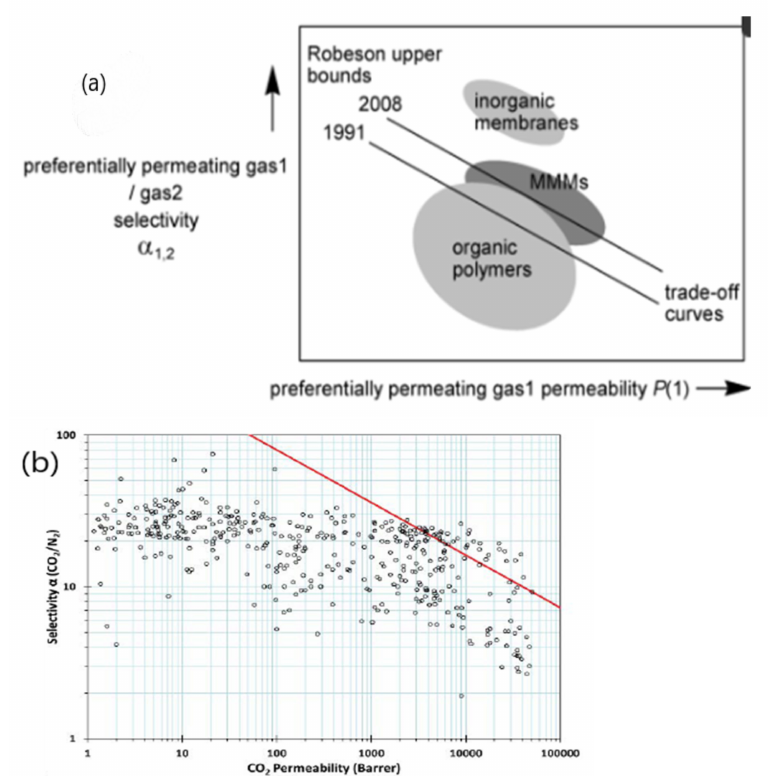
Figure 8. ( a ) Robeson trade-off limit between permeability/selectivity [77]. Reprinted/adapted with permission from Ref. [77]. Copyright 2022, John Wiley and sons ( b ) Robeson plot for gas pair (CO 2 /N 2 ). Red line depicts upper bound 2008. Vacant symbols display the polymers that were listed in membrane society of Australasia